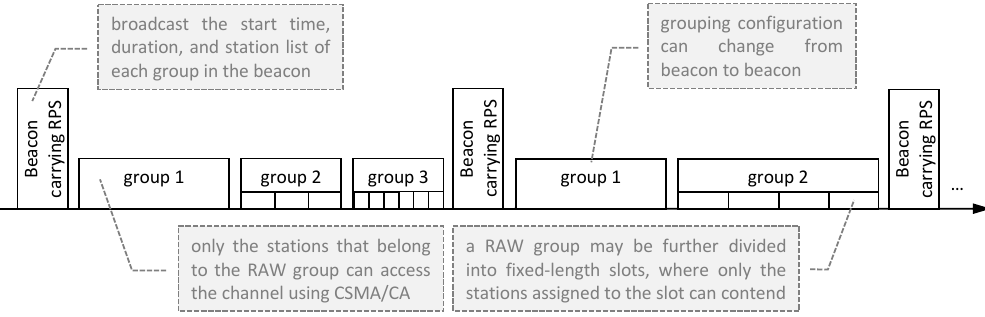
Figure 2. Schematic representation of the RAW